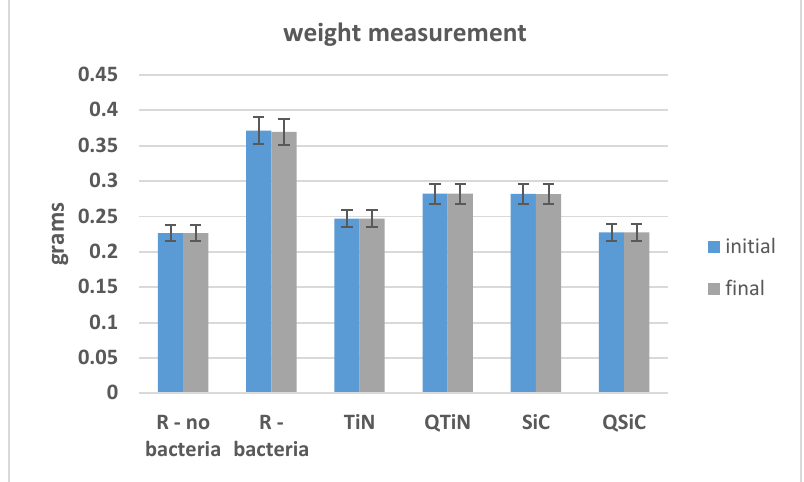
Figure 3. Initial and final weight of Ti disks non-coated and coated before and after 30 days in contact with microorganisms. Table 1. The spatial parameters of AFM for non-coated (Reference) and coated (TiN, QTiN, SiC, and QSiC) disks initially (Day 0) and after 30 days in cultivation with bacteria.